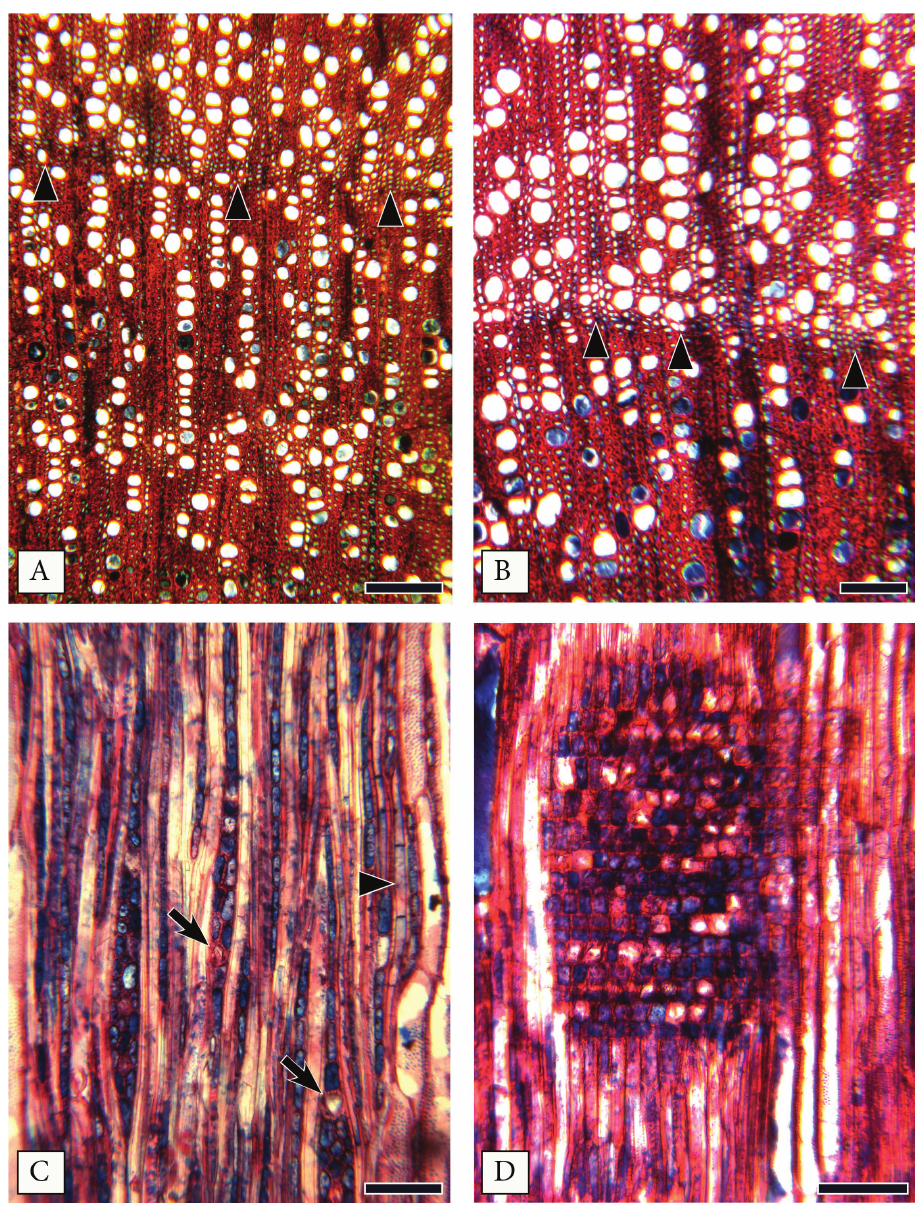
Figure 1. Wood anatomy of Mcvaughia sergipana . A–B transverse sections: Growth rings marked by radially narrow fibers (arrowheads) and a discontinuous line of axial parenchyma (in B); vessels are narrow and abundant, arranged in radial rows of 4 or more cells; some solitary vessels present; parenchyma rare, paratracheal scanty or at the growth ring limits; heartwood vessels in the bottom with content C radial section: Rays 2–3 cells wide, non-storied; prismatic crystals present in ray cells (arrows); parenchyma with 3 cells per strand (arrowhead) D ray heterocellular with procumbent, square and upright cells mixed throughout the ray. Scale bars: 150 μm ( A ), 100 μm ( B–C ), 60 μm ( D